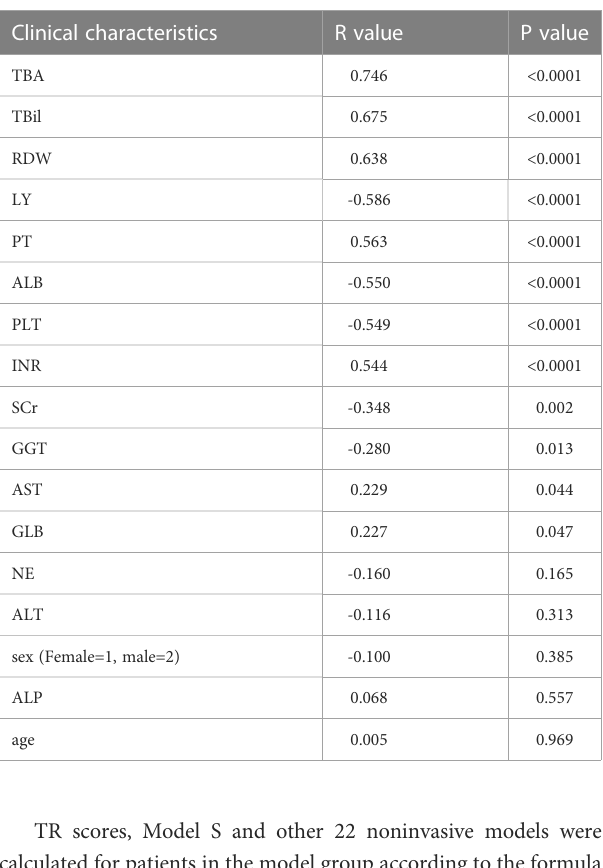
TR scores, Model S and other 22 noninvasive models were calculated for patients in the model group according to the formula shown in the Supplementary Material. 24 models were analyzed for Spearman correlation with the pathological stage as shown in Table 4. All models except the S index and GPR showed signi fi cant correlation (p<0.05) with the pathological stage of